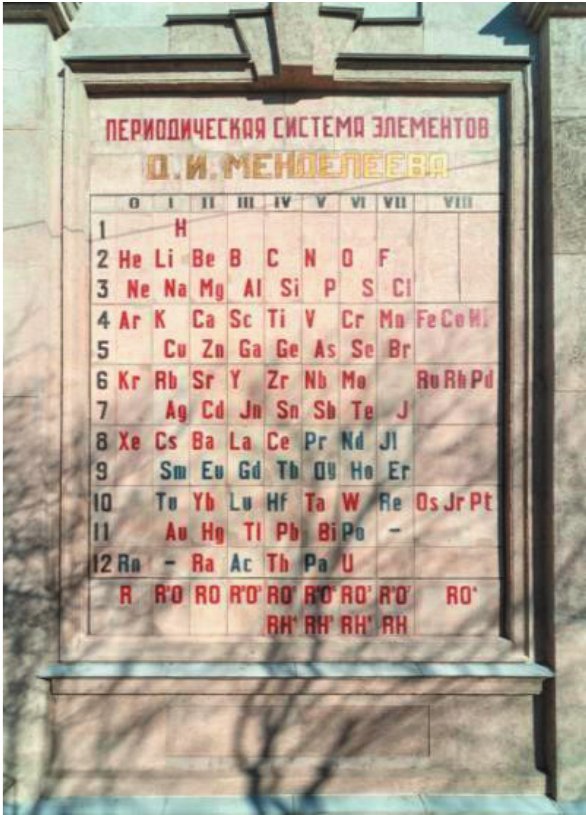
Figure 6. Mosaic panel «D.I. Mendeleev’s Periodic System of the Elements». Photo taken by E.Ginak,